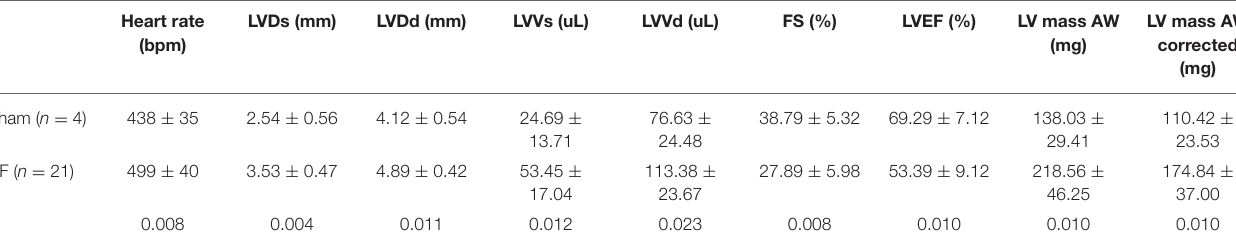
TABLE 1 | Comparisons of echocardiographic parameters between sham-operated and heart failure groups at 10 weeks post-operation and before administration. Heart rate